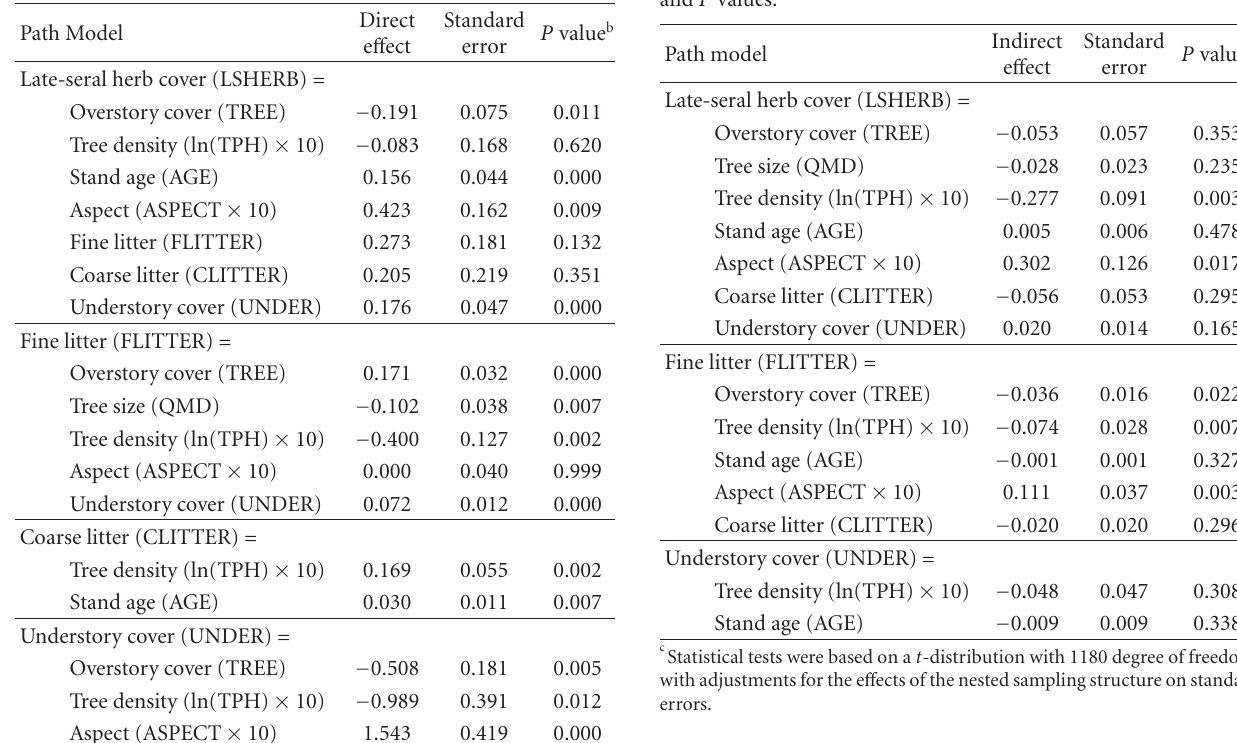
Table 3: Estimated direct e ff ects on the endogenous latent variables in the overstory-understory SR model, along with corresponding standard errors and P values (see Figure 4).